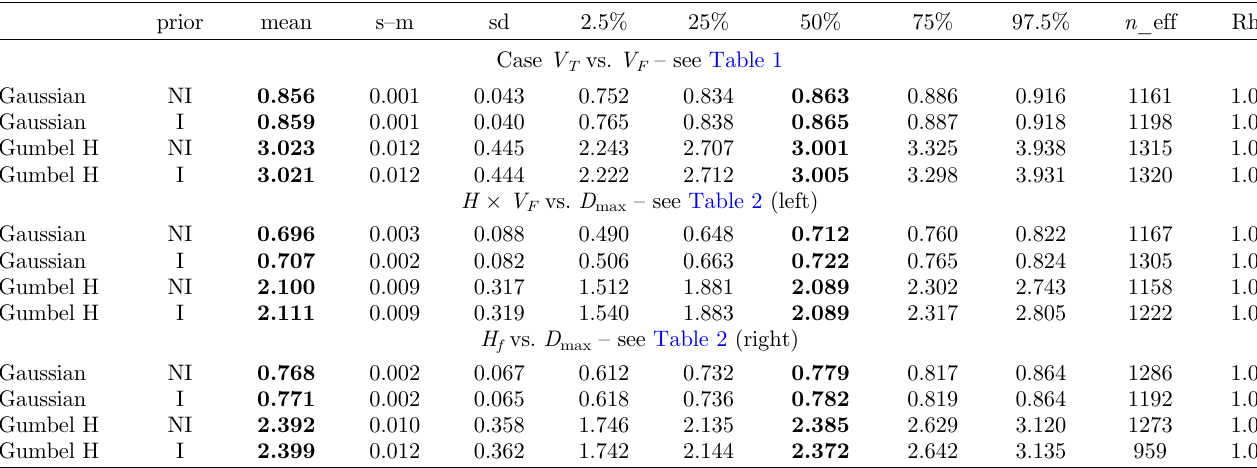
Table 3. Summaries of the Bayesian estimation.